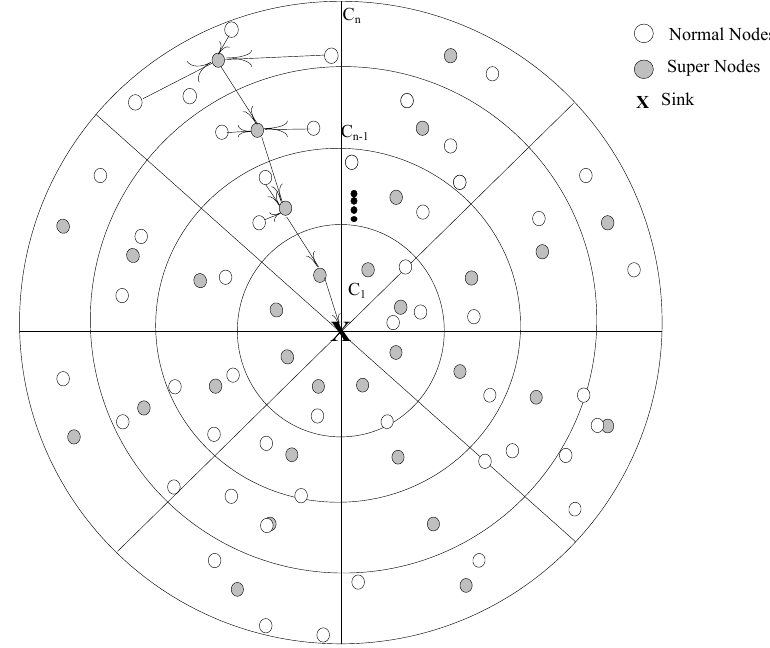
Figure 1. Proposed Network